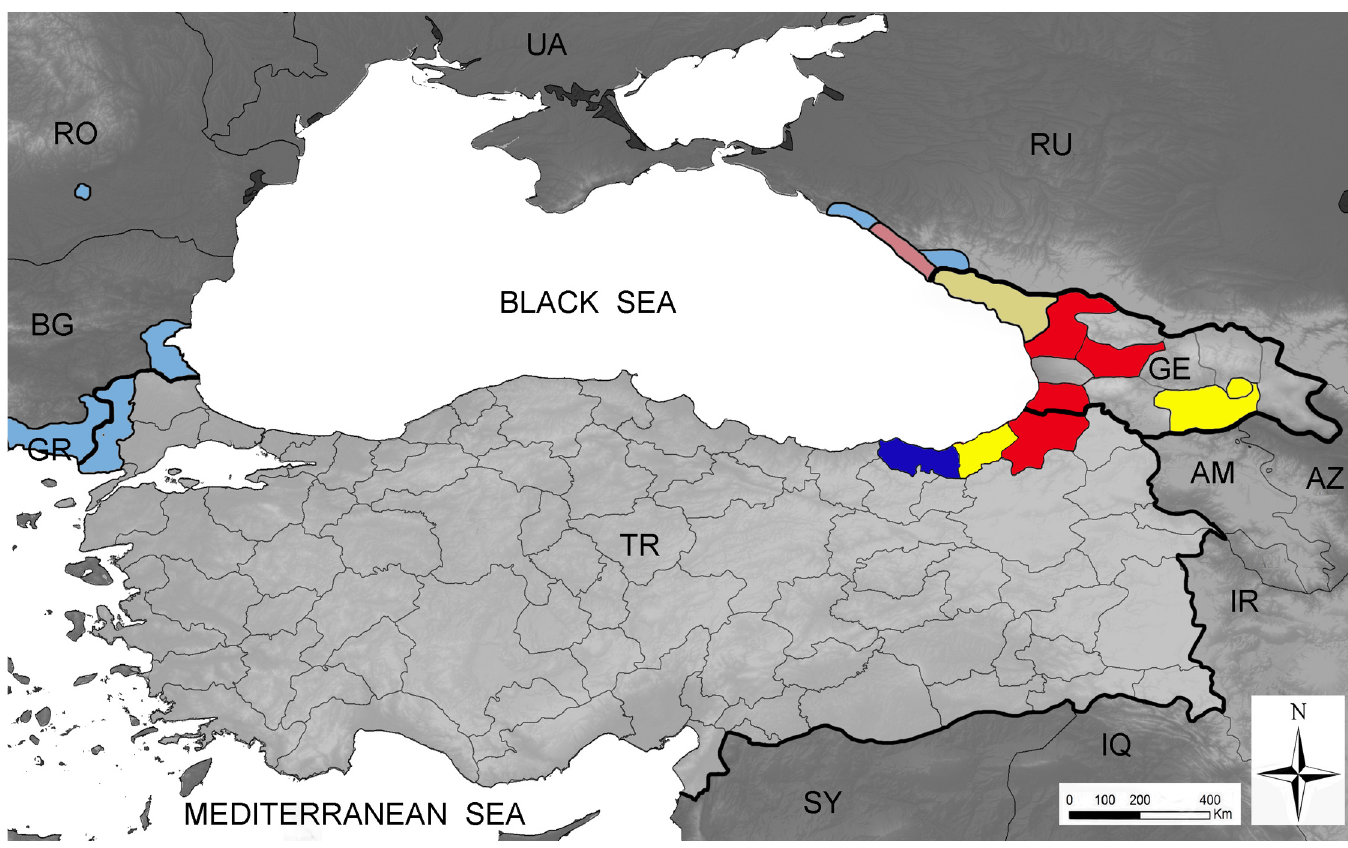
Fig 1. Current known distribution of Aedes aegypti and Aedes albopictus in the Black Sea region. Presence of the mosquito species is shown at province/district level (except for Russia, where the colonised area is much undersized). Light colours: known distribution up to August 2015; Dark colours: surveillance results, September 2015; Yellow: presence of Aedes aegypti, the yellow fever mosquito, only; blue: presence of Aedes albopictus, the tiger mosquito, only; red, presence of both Ae. aegypti and Ae. albopictus. AM: Armenia; AZ: Azerbaijan; BG: Bulgaria; GE: Georgia; GR: Greece; IQ: Iraq; IR: Iran; RO: Romania; RU: Russia; SY: Syria; TR: Turkey; UA: